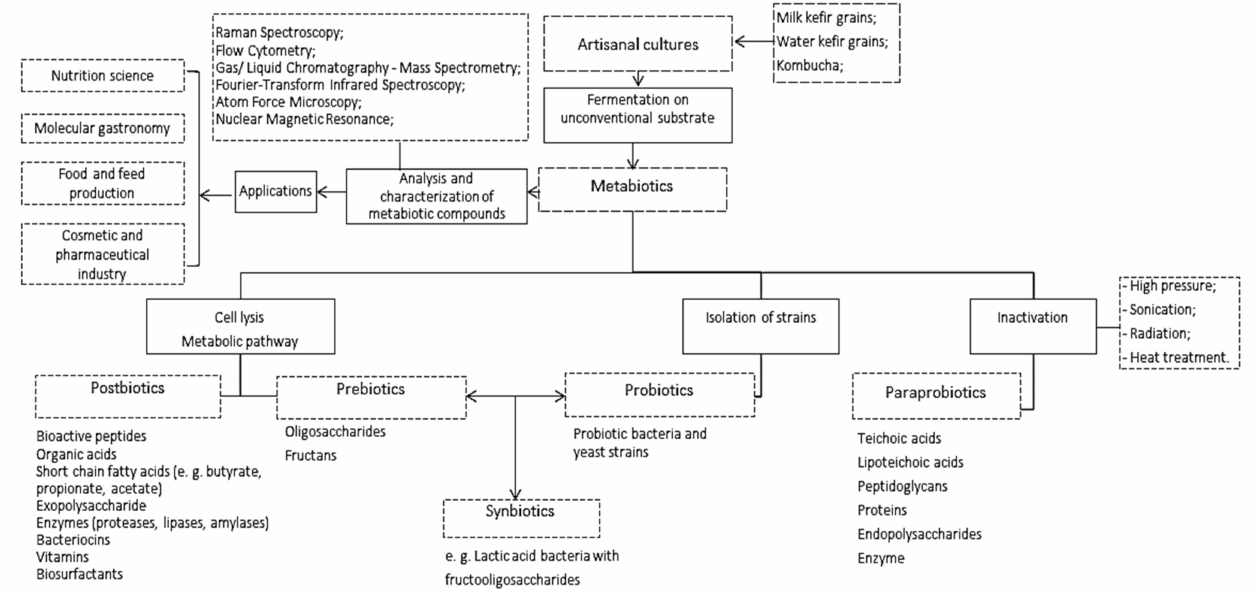
Figure 1. Artisanal cultures as valuable multi-promoters of